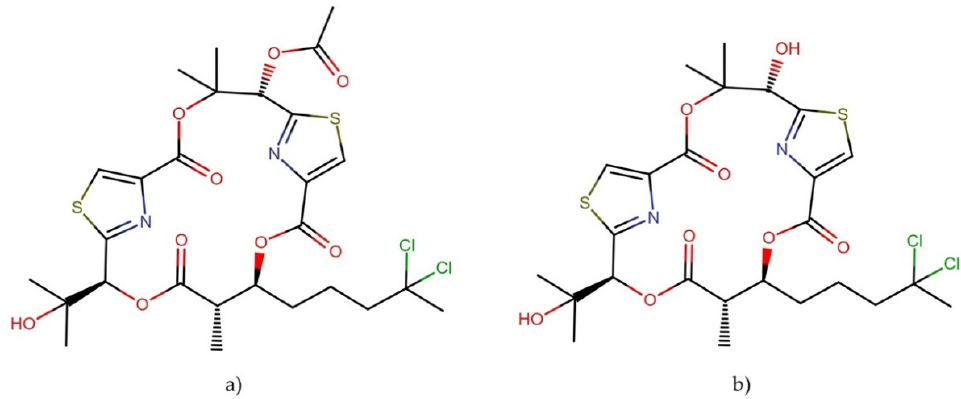
Figure 16. Chemical structures of ( a ) hectochlorin and ( b ) hectochlorin B.